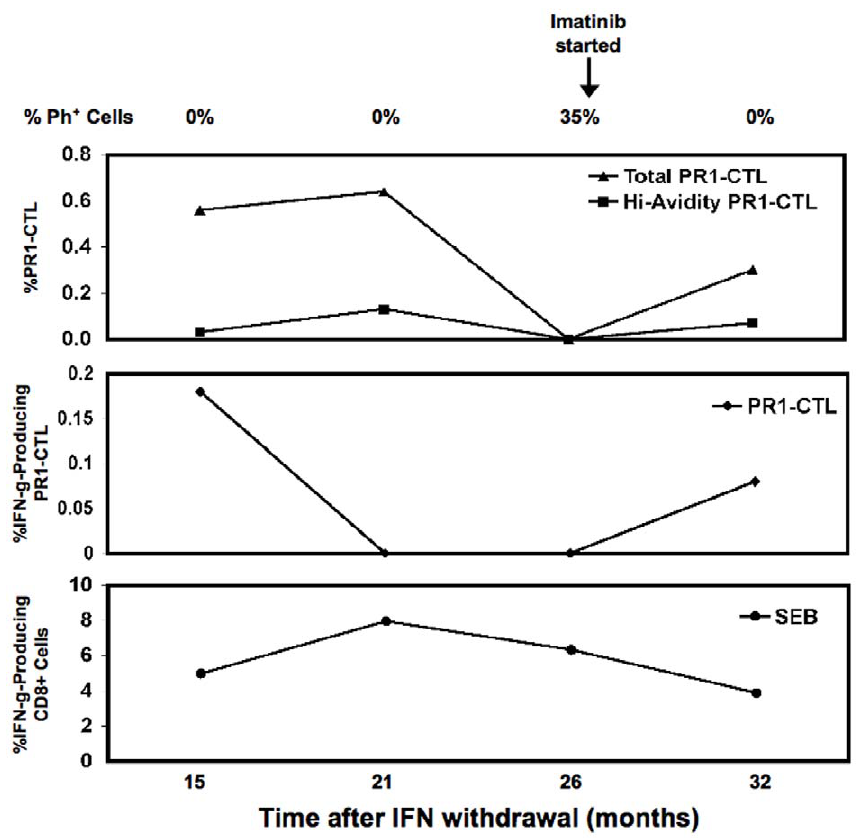
Figure 6. Loss of functional PR1-CTL precedes cytogenetic relapse in patient 2. Staining with the PR1/HLA-A2 tetramer was done to determine the percentage of high- and low-avidity PR1-CTL as described in the methods. In the top panel, PR1-CTL are defined as CD8 + Lin- PR1/ HLA-A2-tetramer + . The center panel shows the percentage of CD8 + lymphocytes that produce IFN c in response to stimulation with 0.2 m M PR1 peptide after subtracting the percentage of CD8 + cells that produced IFN c in the absence of stimulation. Non-stimulated cells were used to adjust background. Stimulation with SEB superantigen was used to confirm that the lymphocytes were not anergic. The lower panel shows the frequency of CD8 + cells that produce IFN c in response to SEB stimulation.